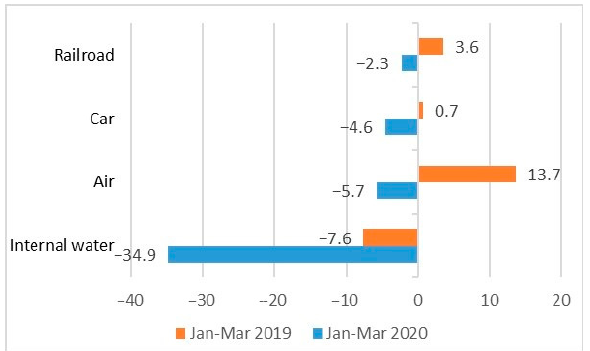
Figure 2. Dynamics of passenger turnover by type of transport in January–March 2020 and in January–March 2019, as a percentage of the same period in the previous year [68].